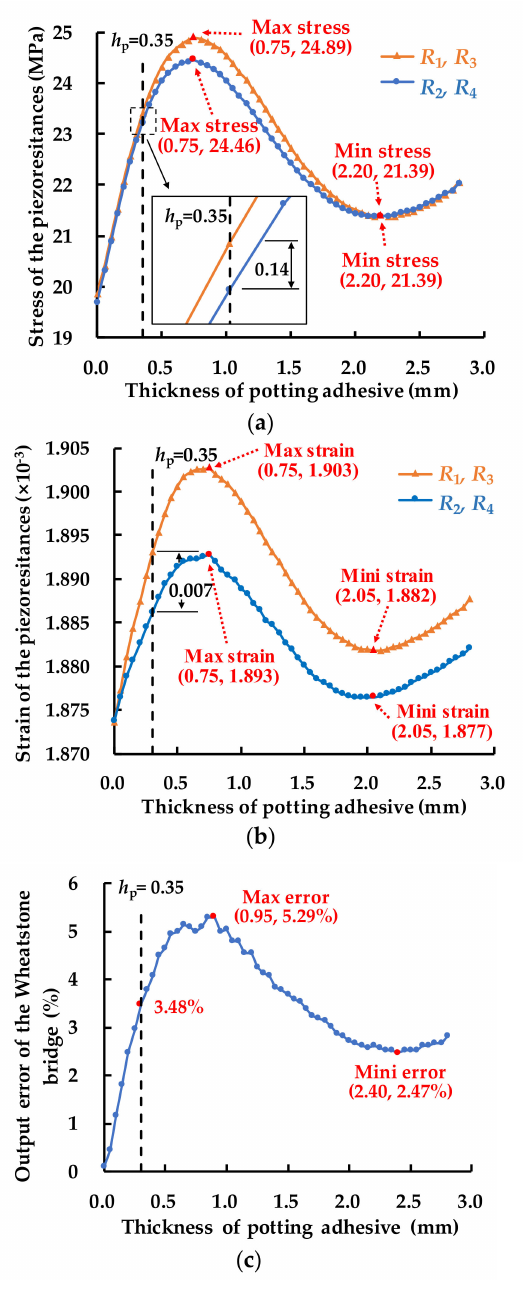
Figure 12. ( a ) Stress and ( b ) strain of the piezoresistances at different h p at 150 ◦ C; ( c ) output voltage error of the Wheatstone